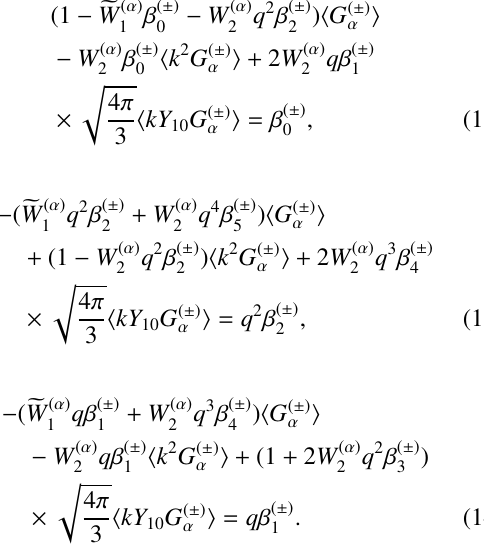
Figure 1. (Color online) The finite temperature ( T = 2 , 4 , 8 MeV) HF and RPA strength functions at q = 0 . 2fm − 3 as functions of p (left panels) and p n (right panels) transi- energy ω for n → → tions. The dashed curves give the strength function for the non- interacting Fermi gas (FG). Note, that the strength functions are scaled by the factor shown inside each